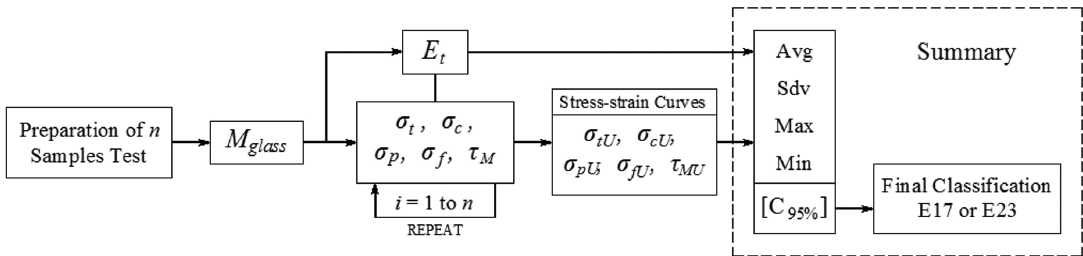
Figure 7. Summary of the performed experimental investigation and final classification of Brazilian GFRP element for structural applications. Table 3. Summary of mechanical properties and final classification of GFRP element analyzed. Test